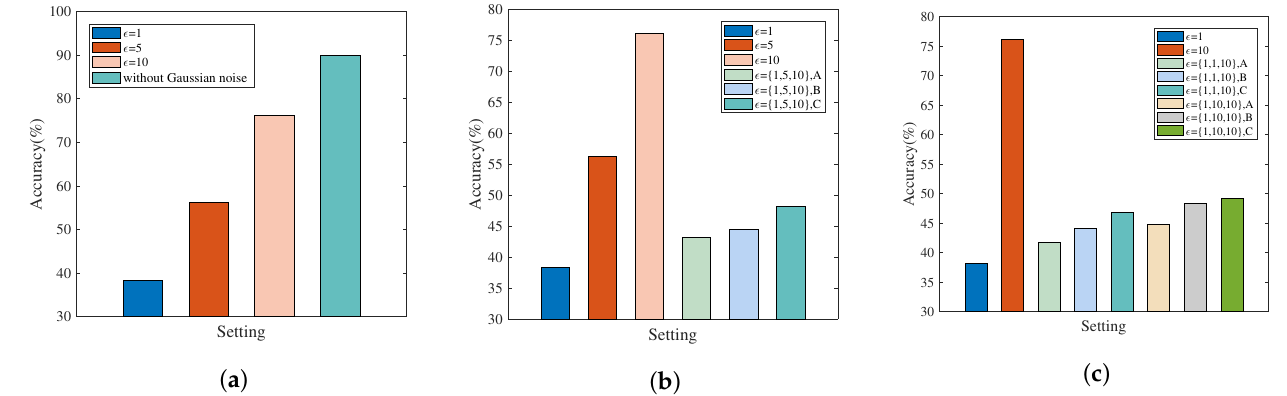
Figure 2. Simulation results on MNIST data. Clients’ training data are independent and identi- cally distributed. ( a ) The non-personalized scenario. ( b ) The personalized scenario under the first privacy setting. ( c ) The personalized scenario under the second privacy setting.